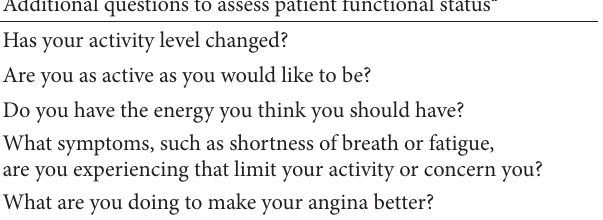
Table 3: Additional questions to assist in evaluation of patient angina